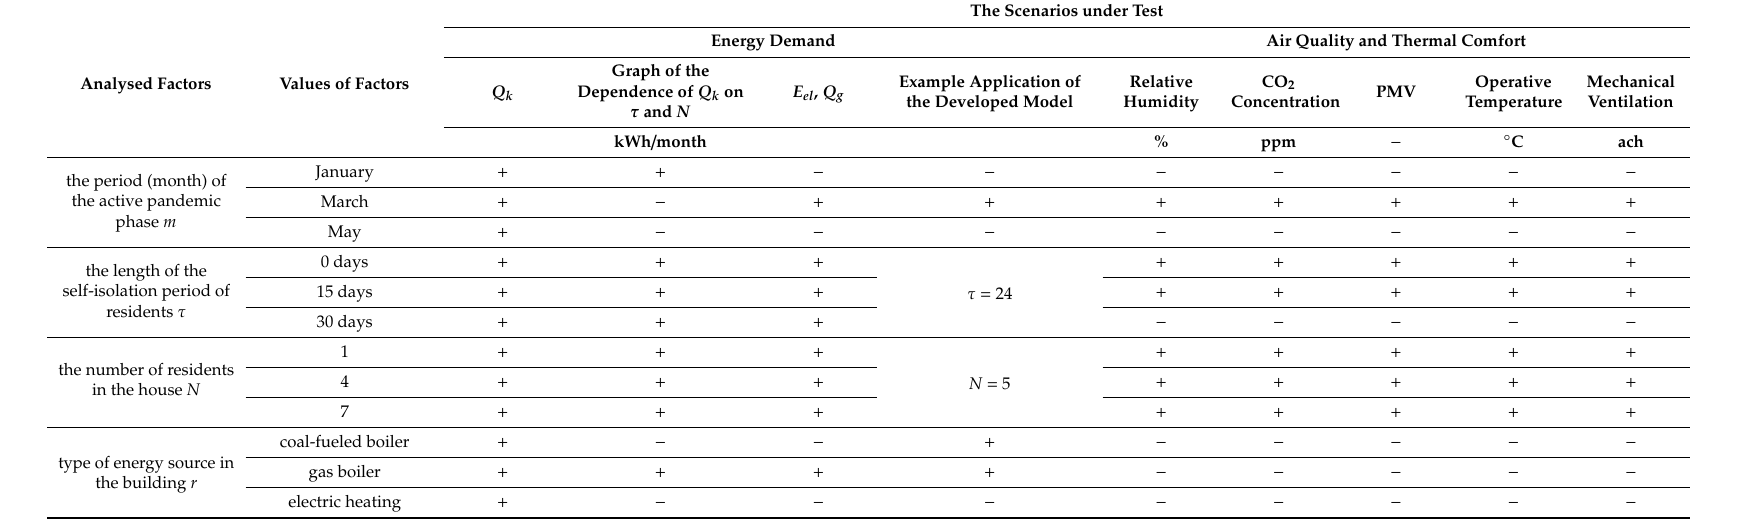
Table 5. Analysed factors and scenarios under